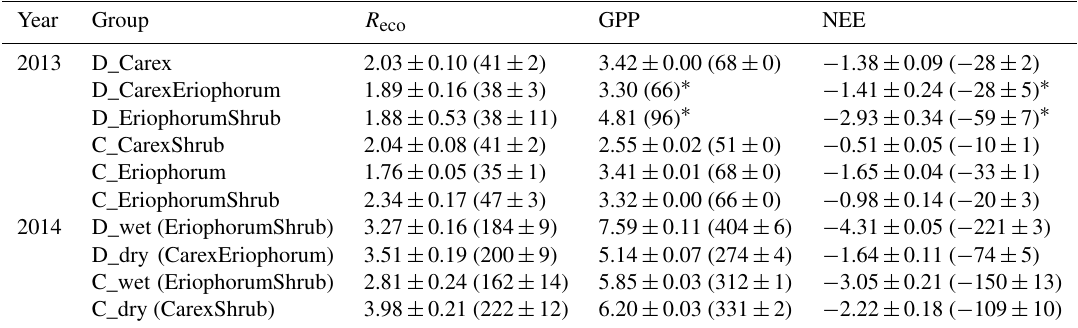
Table 4. Average daily flux (g C-CO 2 m − 2 day − 1 ) from interpolation for the period of 22 July–10 August (20 days) in both 2013 and 2014. Values in parentheses are cumulative flux (g C-CO 2 m − 2 ) for the period of 22 July–10 August (20 days) in 2013 and 16 June–20 August (66 days) in 2014. Results represent the fits of all data points ± SD from bootstrapping. NEE was calculated by subtracting GPP from R eco : positive values are net CO 2 emission to the atmosphere, and negative values are net CO 2 uptake by the terrestrial ecosystem. R